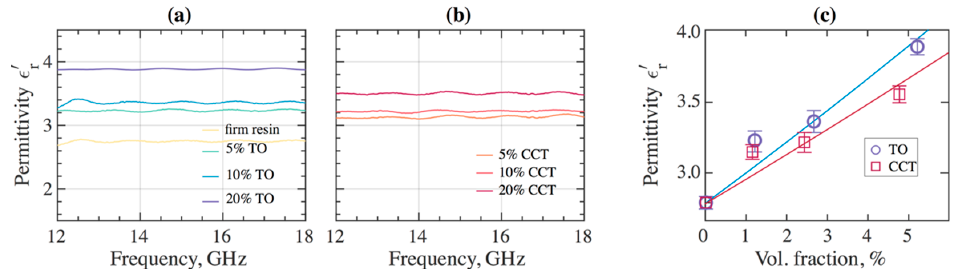
Figure 6. The relative permittivities of the DPP 3DP samples with dispersed ( a ) TO and ( b ) CCT ceramic powder measured by the conventional waveguide method. ( c ) The corresponding average values of the dielectric permittivity as a function of volume fraction (note, that (a,b) shows the value for wt/v%) and solid curves represent the fitting of the experimental values by the effective medium theory [50].